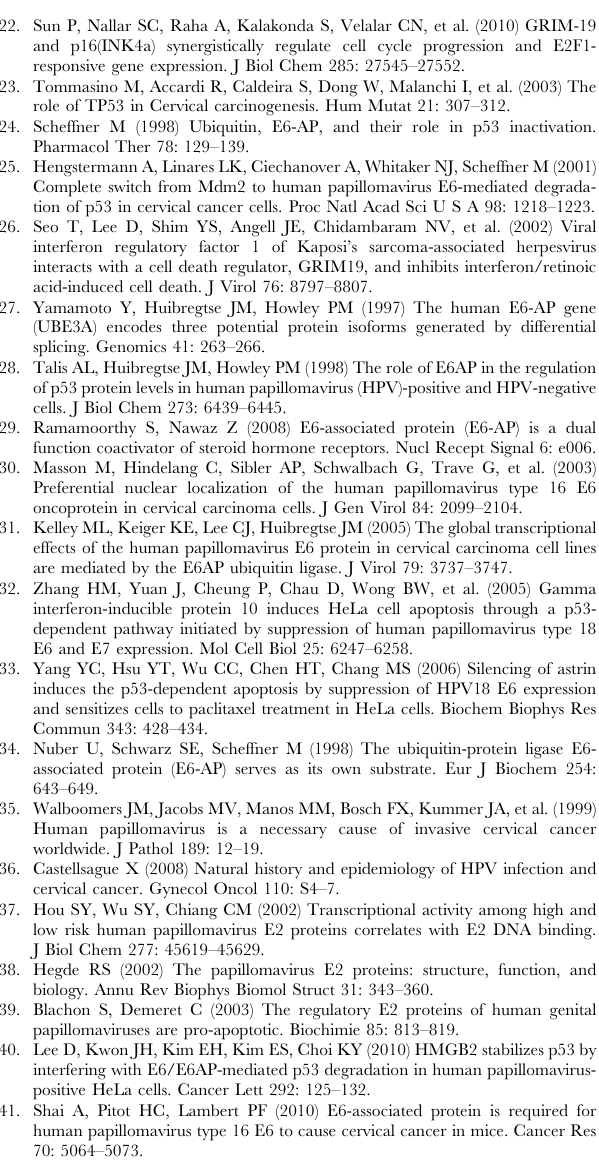
Table S1 List of oligonucleotides used in this